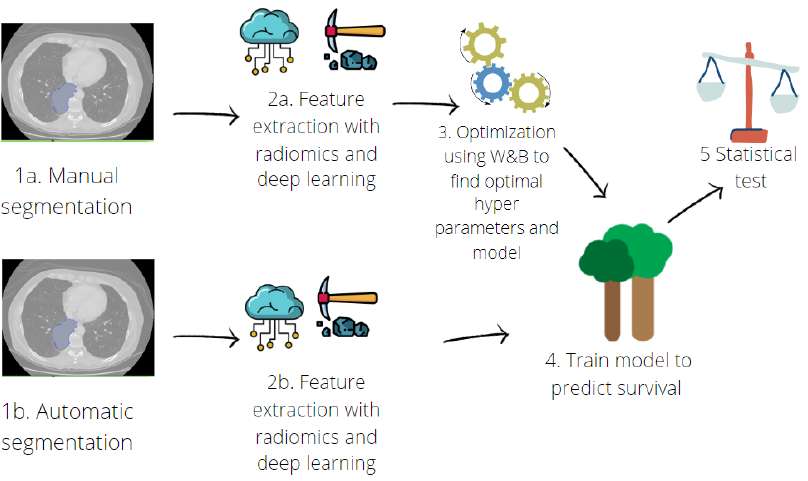
Figure 2. Pipeline for predictive model implementation. Hand-crafted and deep features were ex- tracted ( 2a ) from manual contours ( 1a ). Then, an optimisation step was performed ( 3 ) with a random search across the hyperparameters of three different machine learning algorithms: Random Forest, Support Vector Machine and Multilayer Perceptron. Once the best model was found, deep-learning and radiomic features were also extracted from contours obtained with automatic segmentation ( 1b , 2b ). The predictive model was trained ( 4 ) on features extracted from both manual and automatic segmentation, and a ten-fold cross validation was performed. Finally, performances were compared using a t -test ( 5 ).